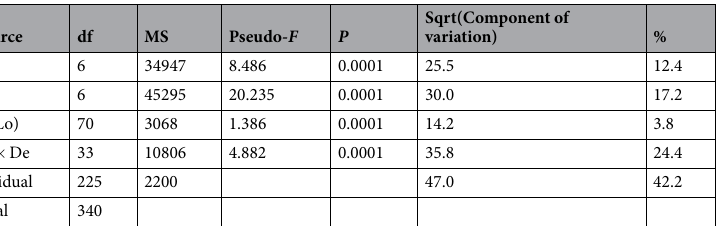
Table 1. PERMANOVA partitioning of fish assemblages on the basis of Jaccard dissimilarities in response to Location (Lo, fixed, 7 levels), Depth (De, fixed, 7 levels) and Transects (Tr, random, nested within Lo) using Type I (sequential) sums of squares. P -values were obtained for each term in the model using 9999 permutations under a reduced model. Estimated sizes of effects for each term in the model are shown in Jaccard units as the square-root of the pseudo multivariate component of variation. Variation attributable to each term in the model is also expressed as a percentage of the total (%). Note that 4 of the original 345 video deployments were omitted prior to analysis, as there were no fish recorded in